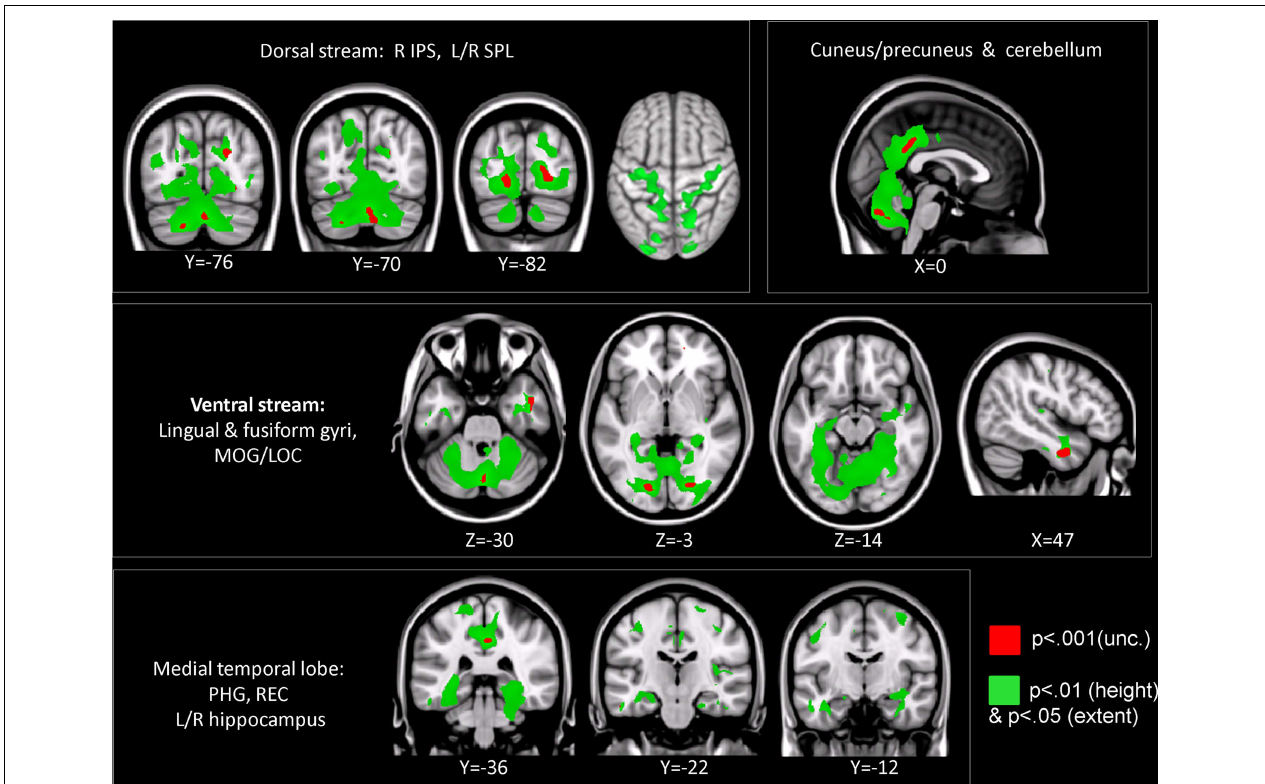
FIGURE 1 | Brain regions where children with DD showed signifi cant gray matter defi cits, compared to TD children (two-sample t -test results for TD > DD contrast). Red: p < 0.001; Green: height threshold p < 0.01, extent threshold p < 0.05 with family-wise error correction for multiple comparisons